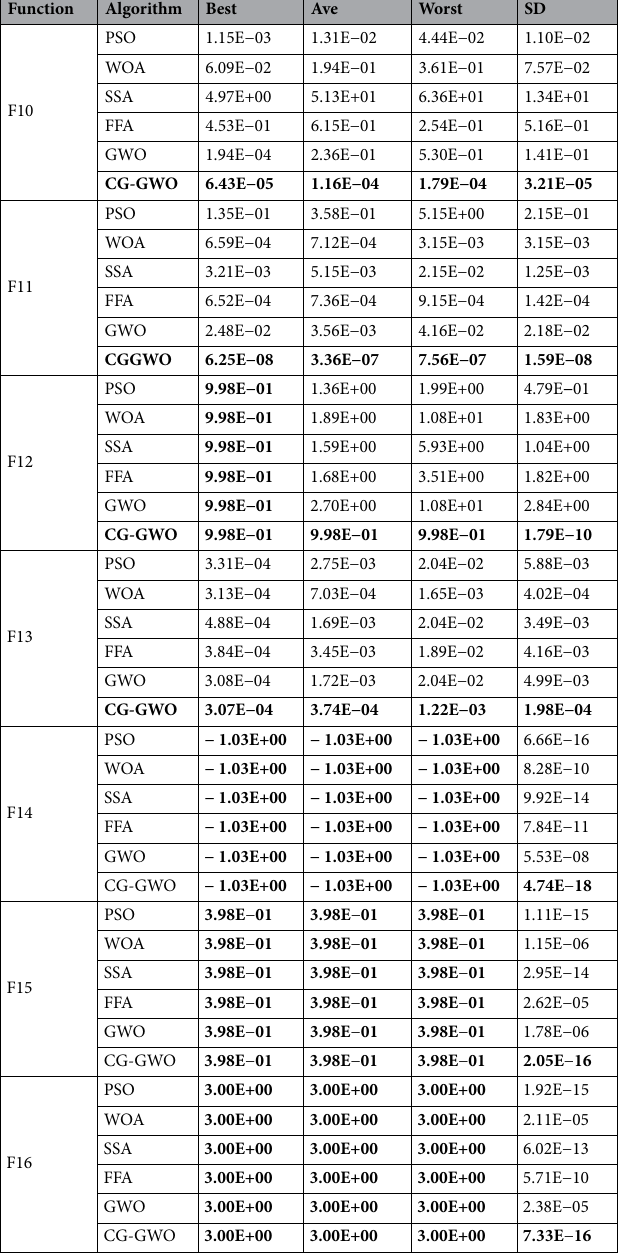
Table 5. Experimental results comparison of classical optimization